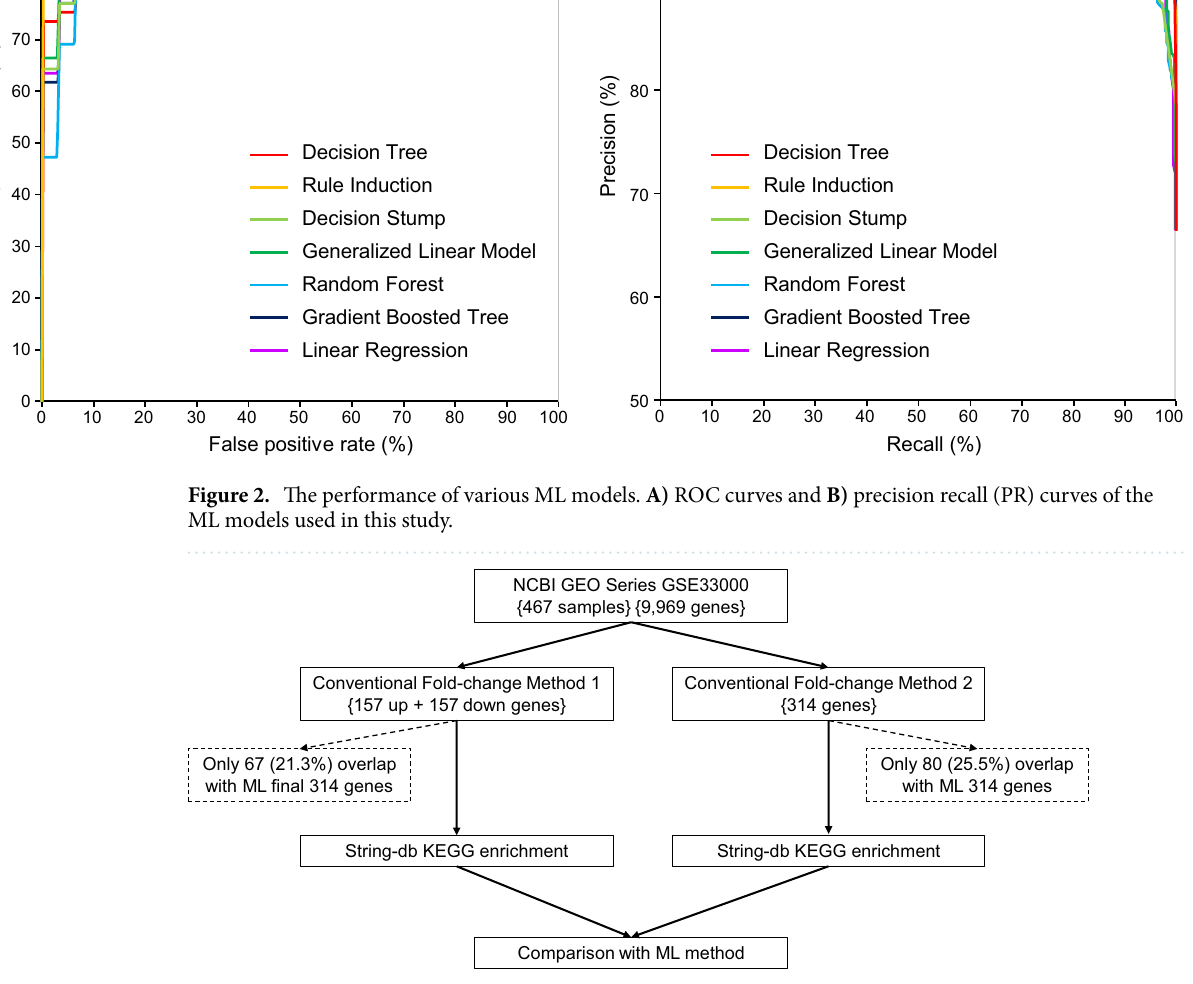
Figure 3. The workflow of identifying dysregulated genes by the conventional FC method. The curly brackets indicate the number of genes that passed the criteria or were identified in each step. The overlap of identified genes between ML and the FC method is shown in dashed